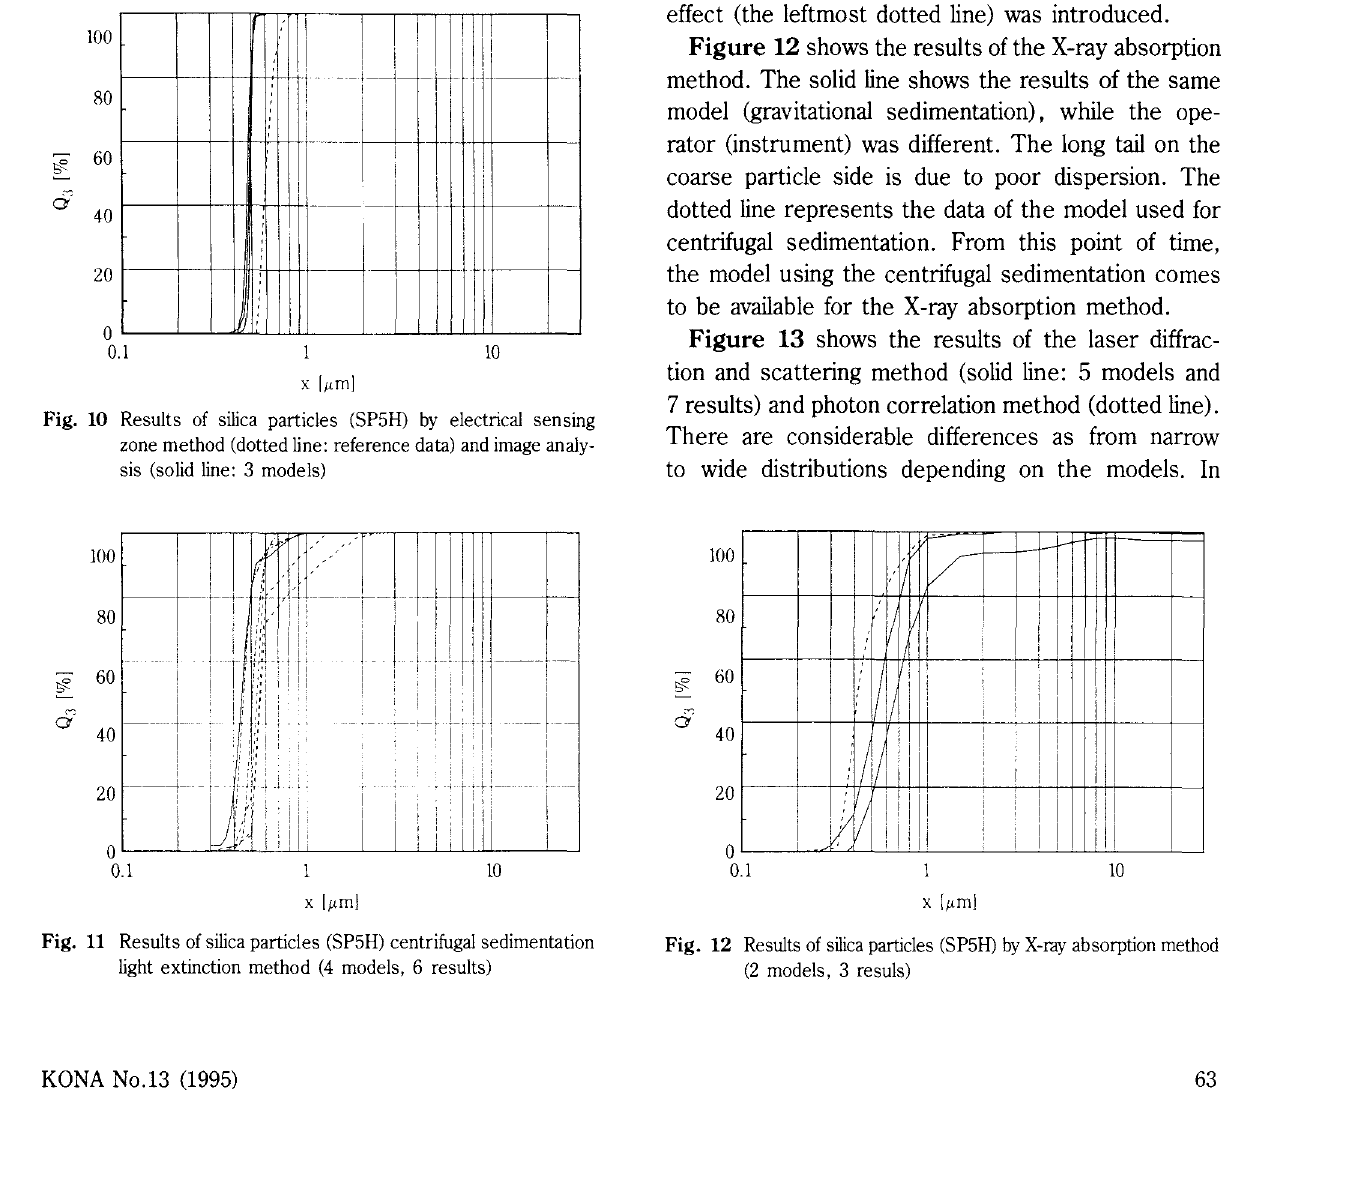
Fig. 12 Results of silica particles (SP5H) by X-ray absorption method (2 models, 3